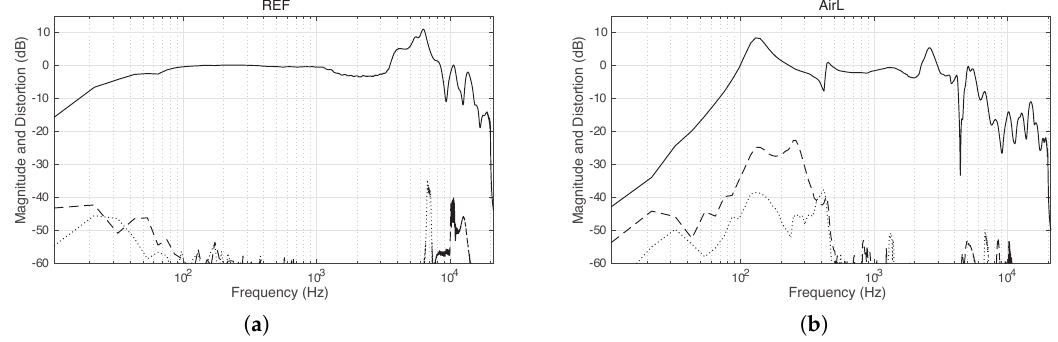
Figure 3. Frequency response with distortion of two headphones (left channel). Solid curve, magnitude; dashed curve, second order distortion harmonic; dotted curve, third order distortion harmonic. ( a ) REF, Reference headphone; ( b ) AirL, Airline